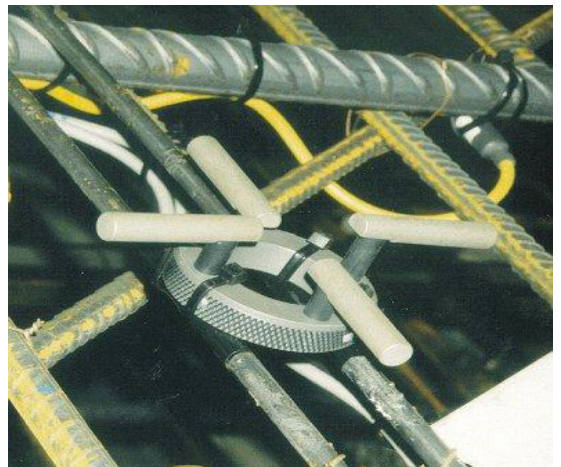
Figure 2. Nagel-System